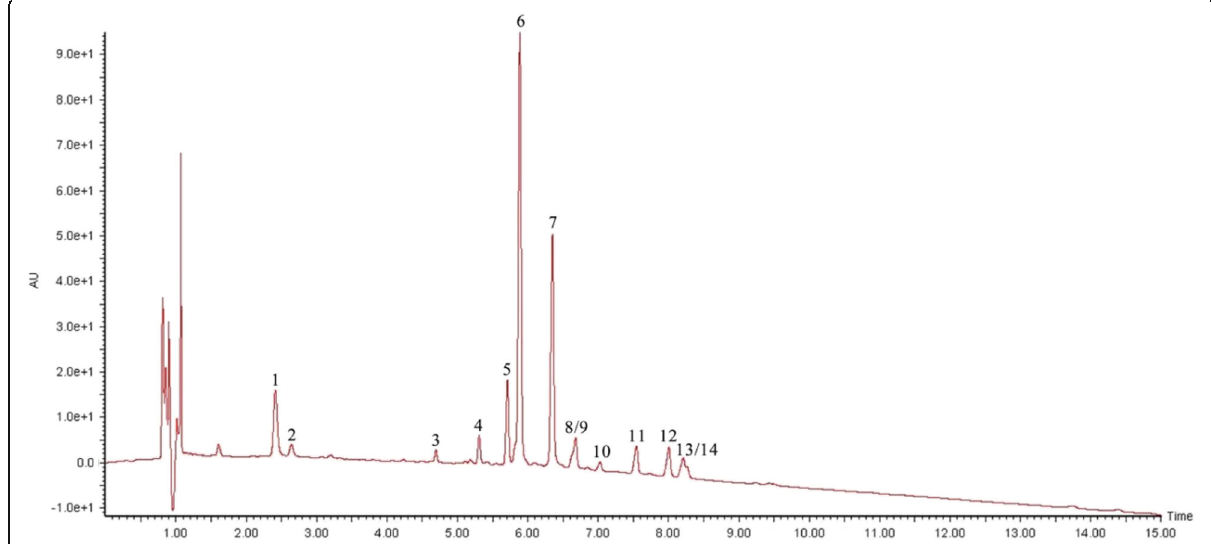
Fig. 1 Base peak chromatogram of G. pensylvanicum extract by UPLC-ESI-MS/MS in the negative ion mode. Peak labelling represents the compounds identified